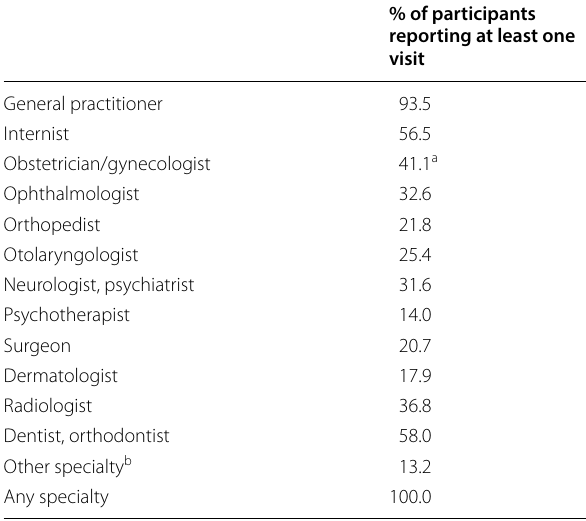
Multiple answers